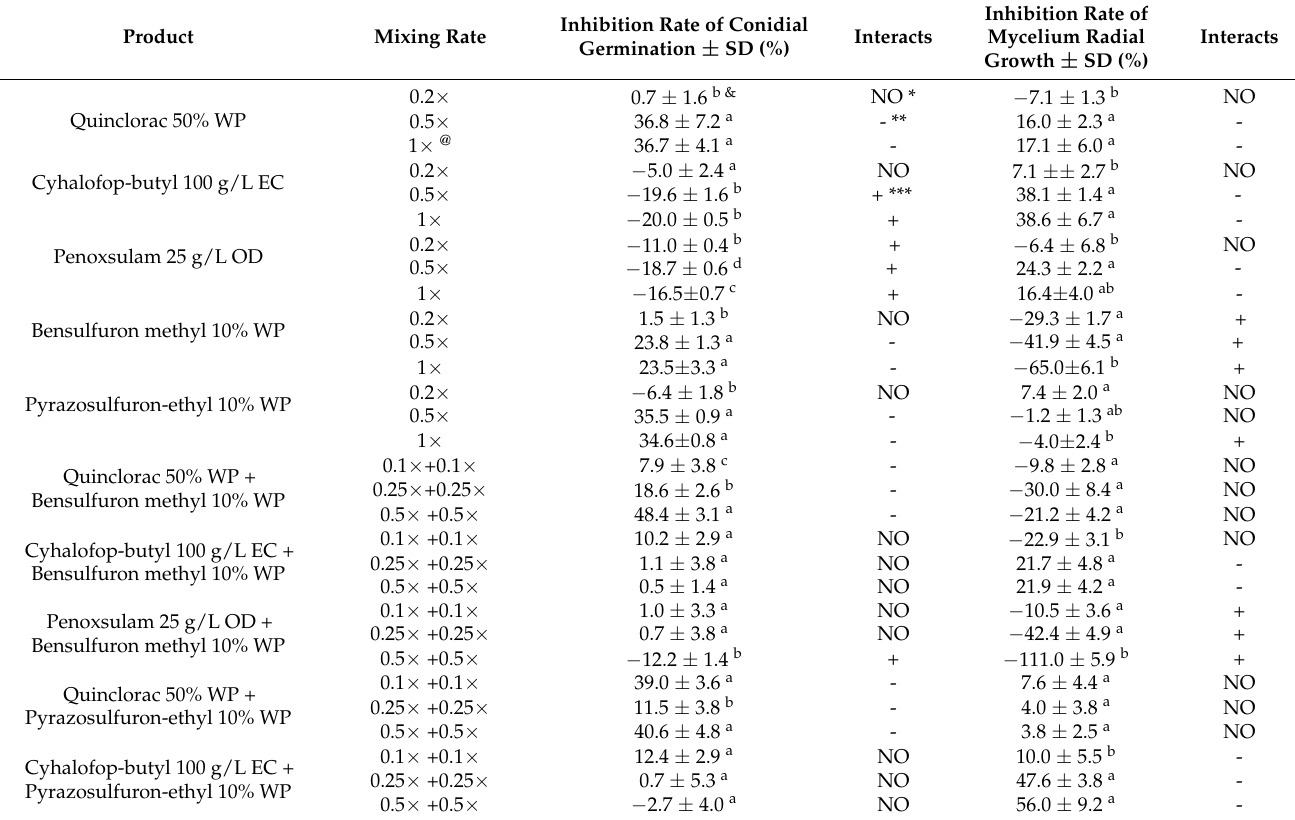
Table 1. Inhibition rate of survival and radial growth of B. eleusines by